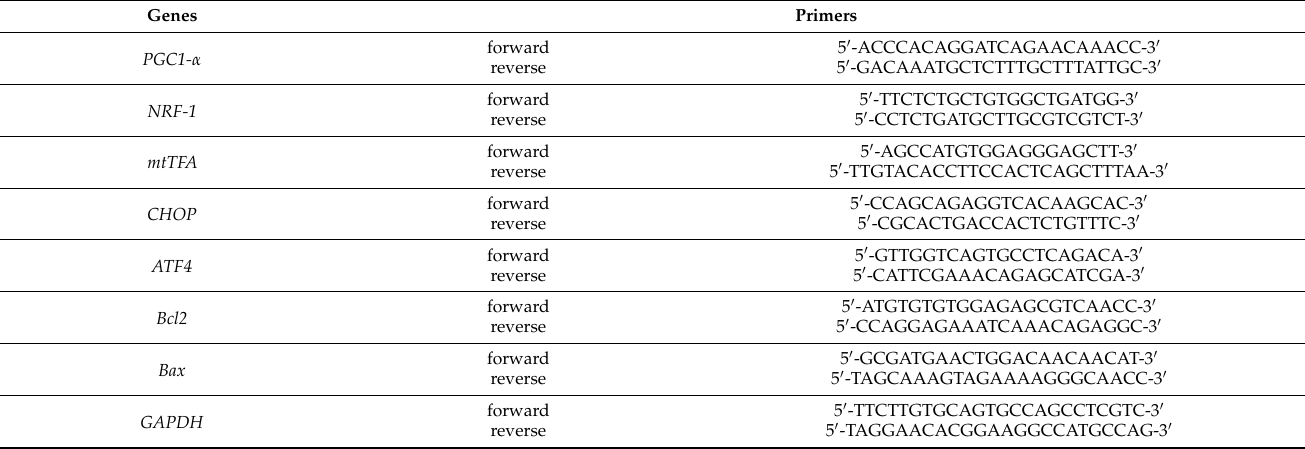
Table 1. Primers used for real-time PCR